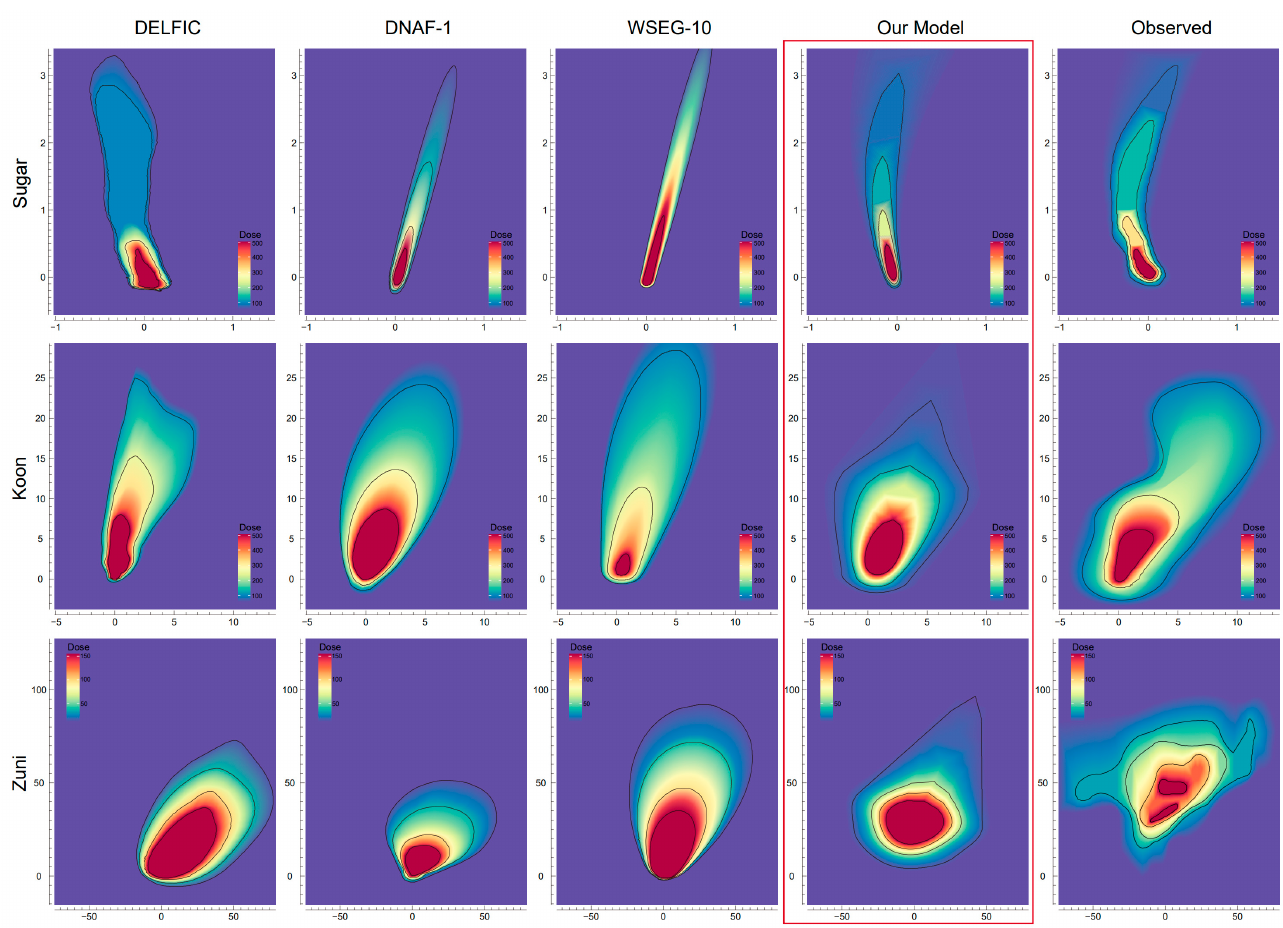
Figure 4. Dose distributions from model predictions and real historical observations for the three nuclear tests.